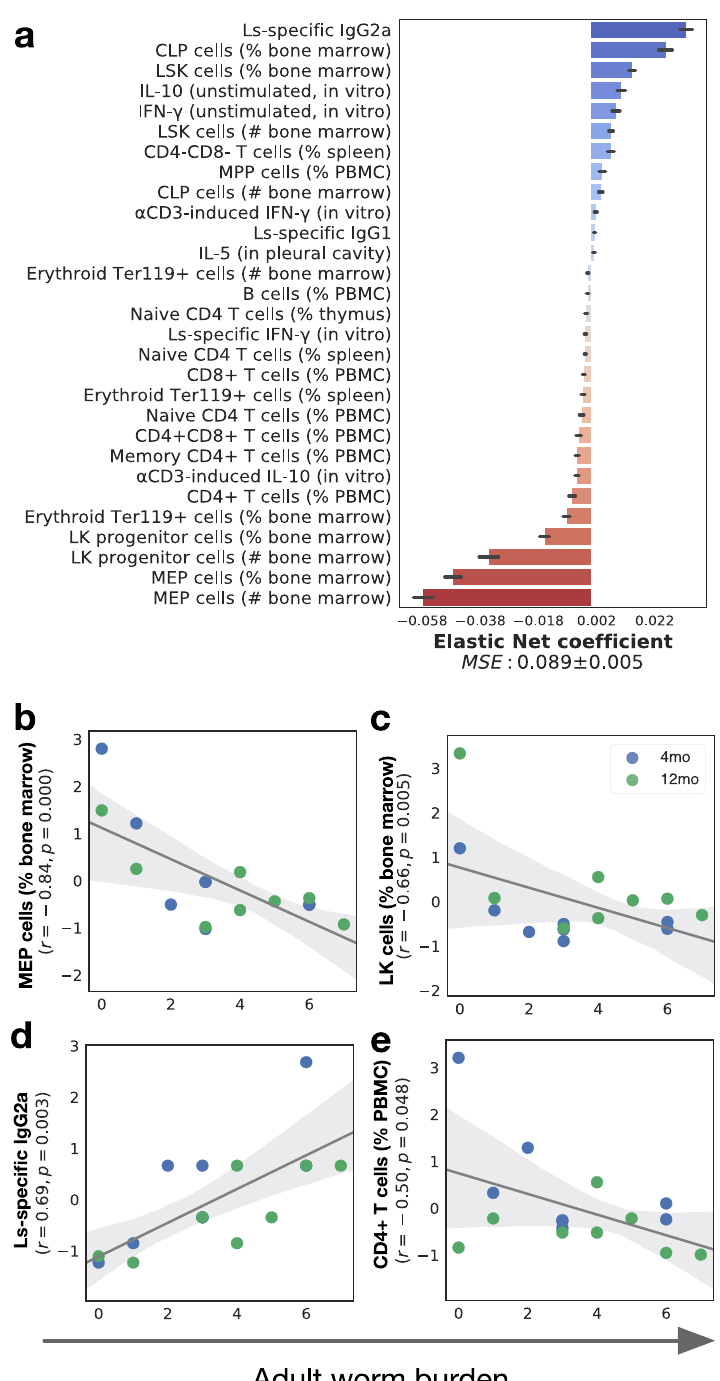
Figure 3. Adult worm burden was negatively correlated with the abundance of MEP, LK, and CD4 T cells, but positively associated with parasite-specific IgG2a titres. ( a ) Elastic Nets were used to map immune features to adult worm burdens 2 months post infection in infected mice only (n = 16). A wide range of cell types, comprising HSPC, innate, and adaptive immune cells, contributed to correctly predicting adult burdens with a mean squared error of 0.089 ± 0.005: the strongest predictors of worm burden among HSPC included ( b ) the proportions of MEP (r = − 0.84; P ≤ 0.001, GLM), ( c ) LK cells, both negatively associated with parasite burdens, and from the peripheral blood circulation (r = − 0.66; P = 0.005, GLM), ( d ) the titre of Ls-specific IgG2a (r = 0.69; P = 0.003, GLM) and ( e ) the proportion of CD4 + T cells among PBMC (r = 0.50; P = 0.048, GLM). Horizontal bars represent means and associated errors of the coefficients applied by the Elastic Net models trained on 10 repeated 75% / 25% random nested splits of the full dataset. In regression plots, each point represents a mouse, the solid line is the robust regression (preferred over least squares to reduce the influence of outliers) and the shaded areas represent the corresponding 95% bootstrapped confidence